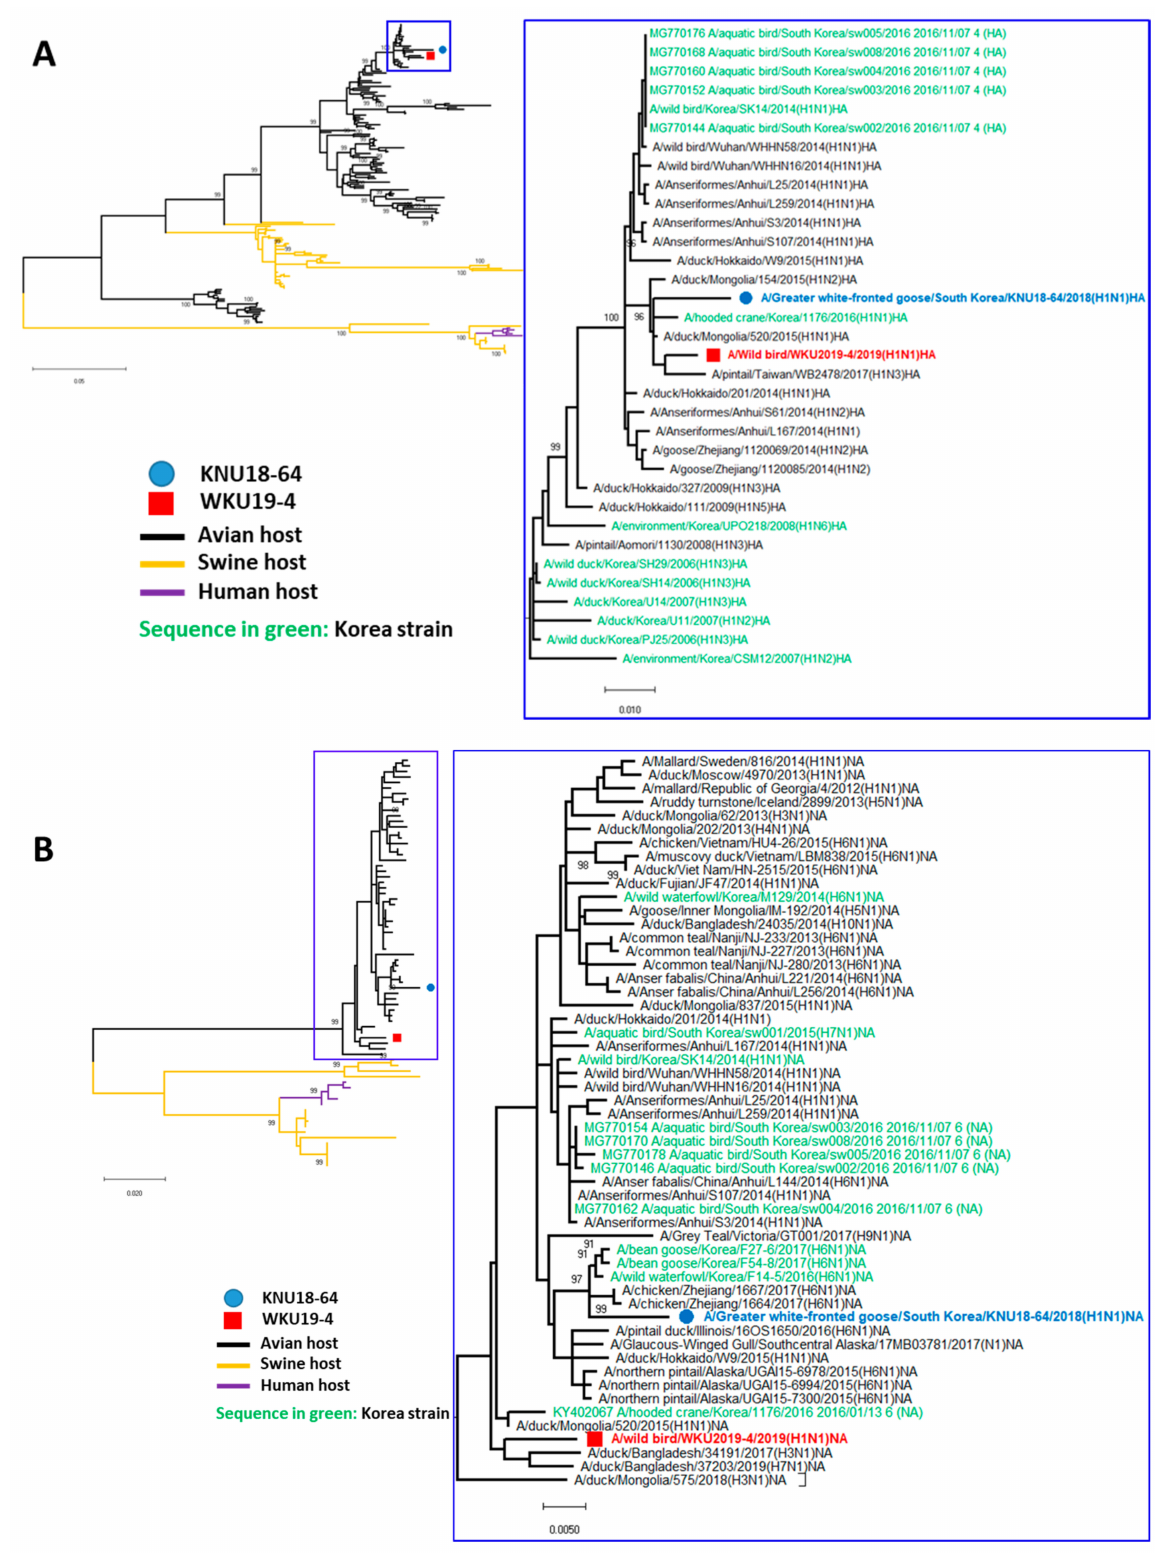
Figure 2 by the sizable distance between the novel isolates (represented by black branches) and the swine strain (yellow branches) and human-infecting strain (purple